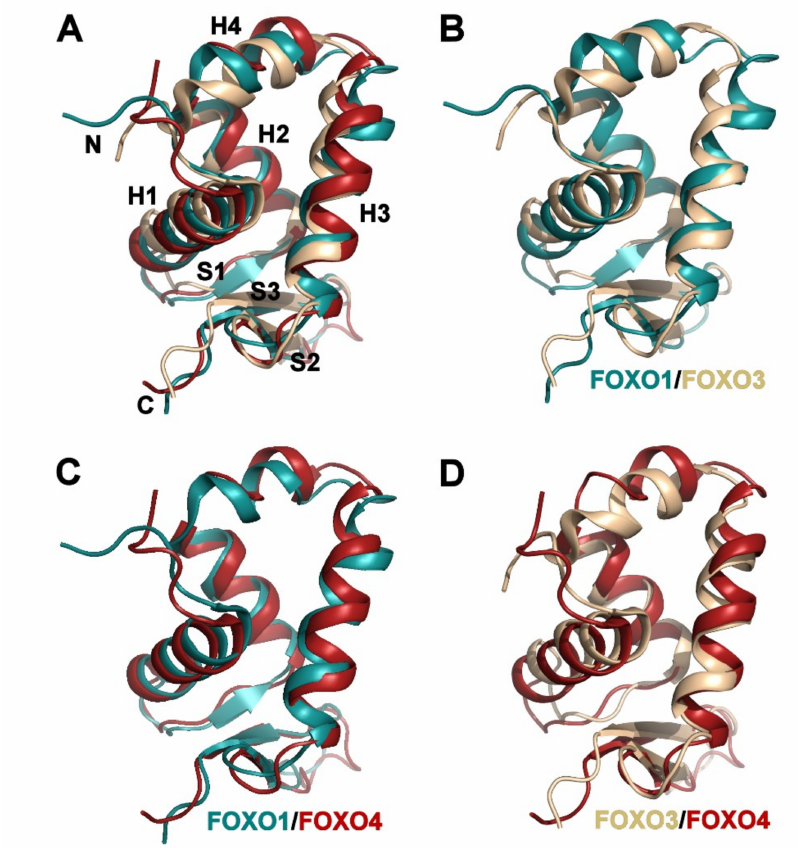
Figure 3. Comparison of FOXO1-DBD with previously reported solution structures of FOXO3-DBD and FOXO4-DBD. ( A ) Superimposition of representative conformers of FOXO1-DBD (conf. no. 16), FOXO3-DBD (conf. no. 11, PDB ID: 2K86 [46]) and FOXO4-DBD (conf. no. 3, PDB ID: 1E17 [45]). Selected conformers are representatives of the most populated clusters obtained by cluster analysis of conformational ensembles of NMR solution structures [47]. Structural comparison was performed using residues 156–239 (mouse FOXO1 numbering). Structures were superimposed using all C α atoms. ( B – D ) Superimposition of FOXO1 / FOXO3, FOXO1 / FOXO4 and FOXO3 / FOXO4